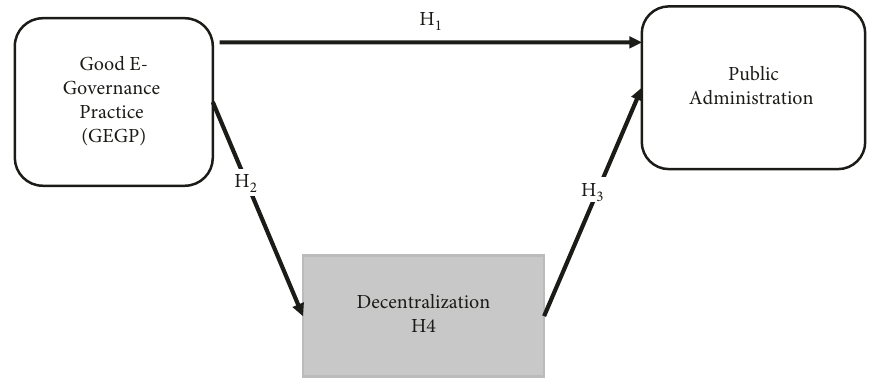
Figure 1: Conceptual framework.